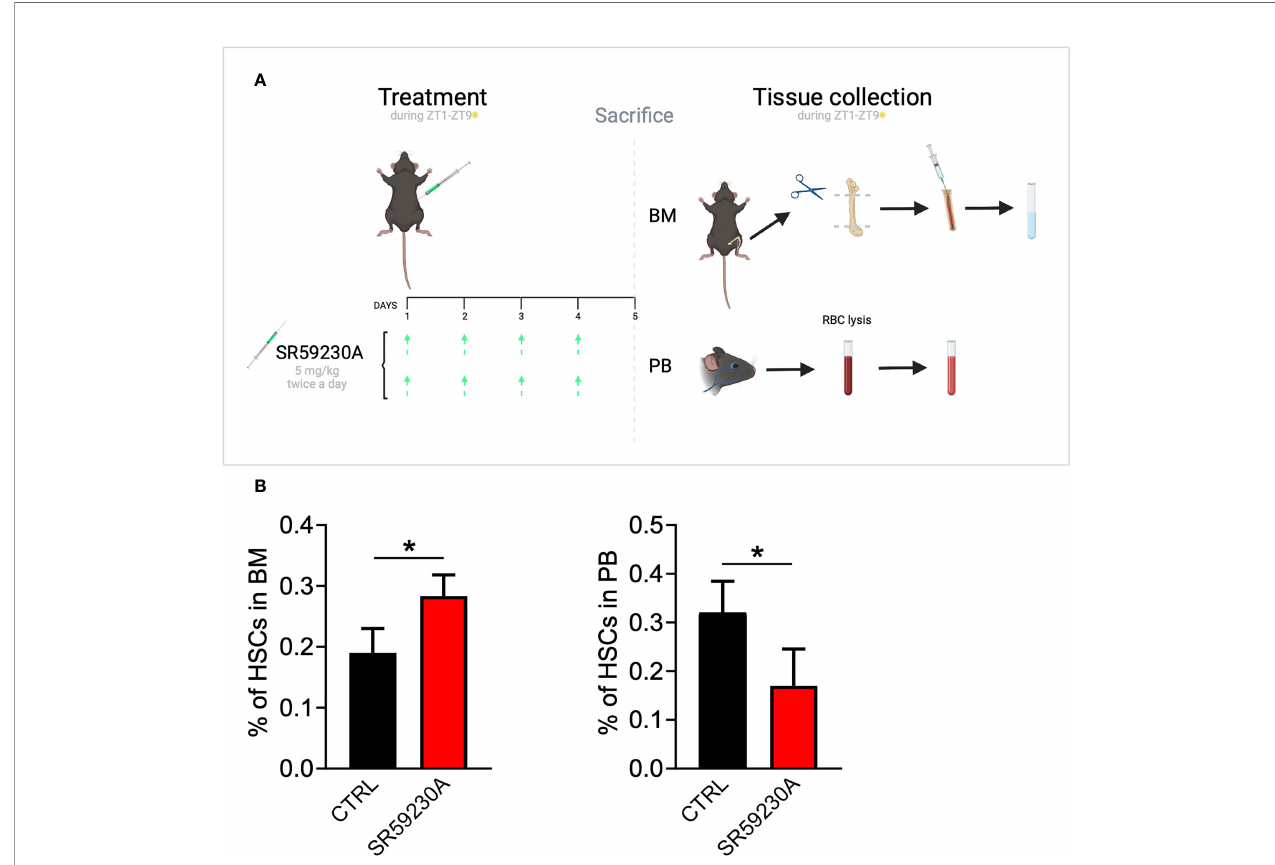
FIGURE 1 | Study of b 3-AR antagonism effect on HSC homing/egress. (A) In vivo model: C57BL/6 mice were treated with SR59230A 5 mg/kg twice a day for 4 days always during light hours (Zeitgeber time 1 – 9). Untreated mice were used as control. BM cells were obtained by fl ushing femur and tibia; PB cells were obtained by a retro-orbital sinus blood collection and the lysis of red blood cells. Samples were always collected during light hours (Zeitgeber time 1 – 9). (B) Flow cytometry analysis was performed by using a MACSQuant Analyzer 10 (Miltenyi Bio-tec). HSCs were identi fi ed as Lin-c-kit+Sca1+ cells. Results were reported as the mean±SD of four replicates. *p <0,05 SR59230A vs.